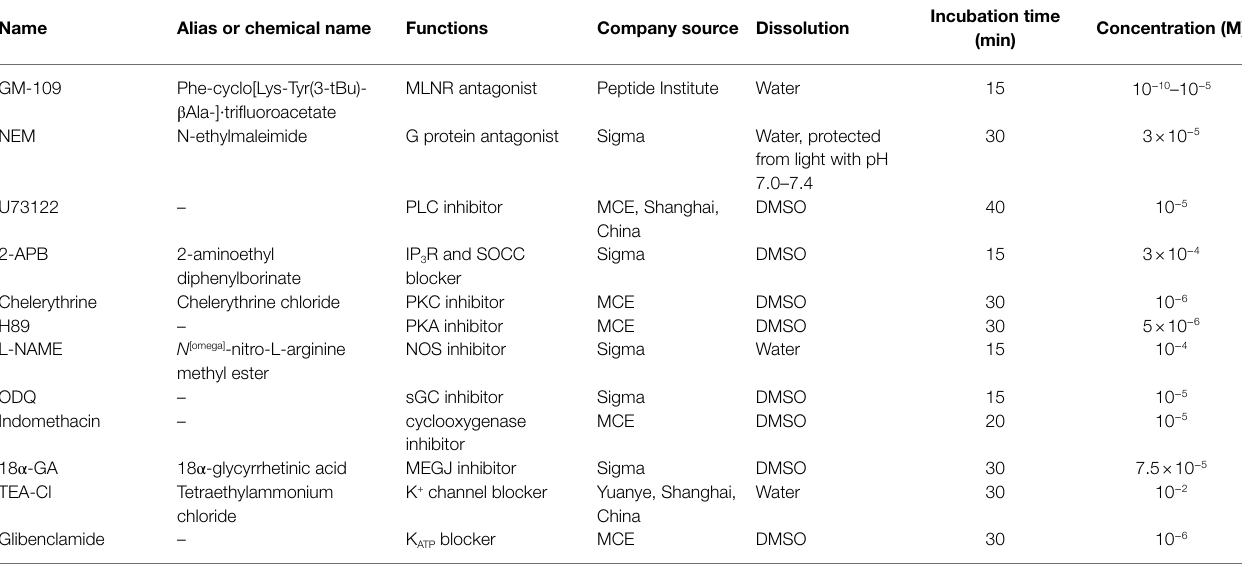
TABLE 1 | Inhibitors/blockers used with their respective mode of action and final